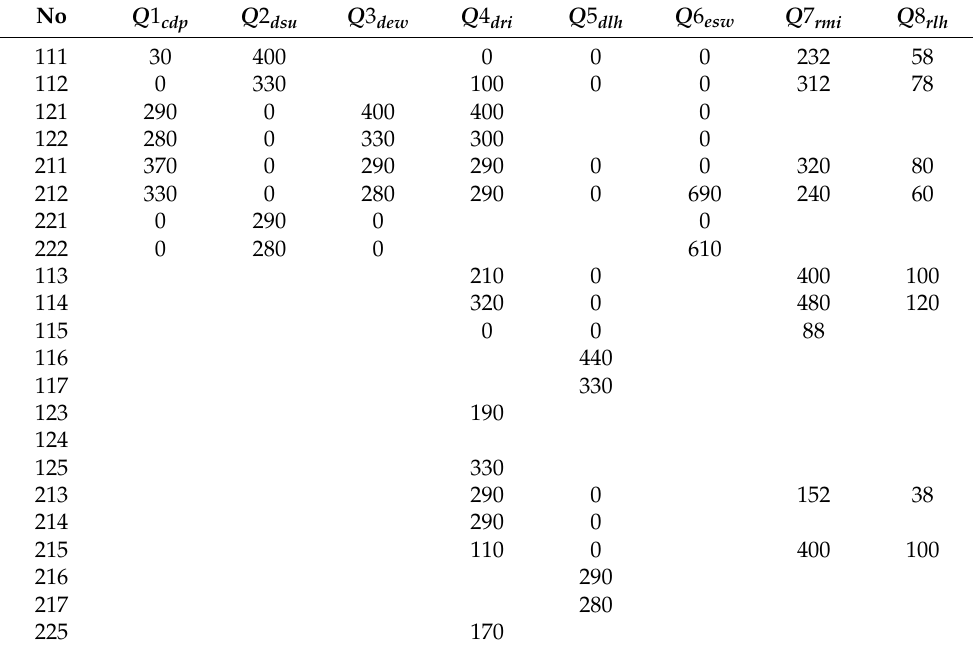
Table 19. The flow of materials and components (2nd